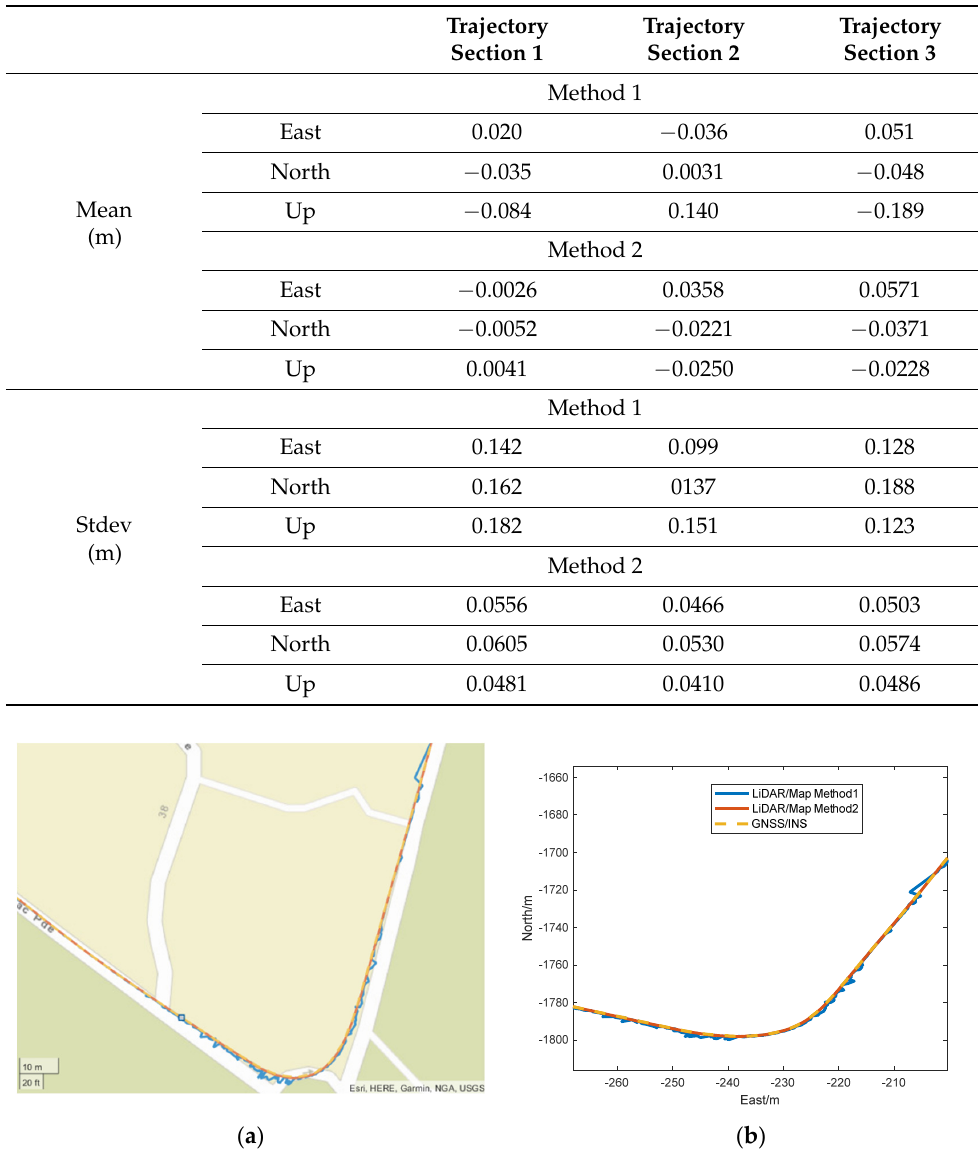
Figure 15. Trajectory of Lidar/map matching-based localization Method 1 (blue), Method 2 (Red) and GNSS/INS localization (Yellow): ( a ) view in Google Map; ( b ) view in local coordinate system around the roundabout.